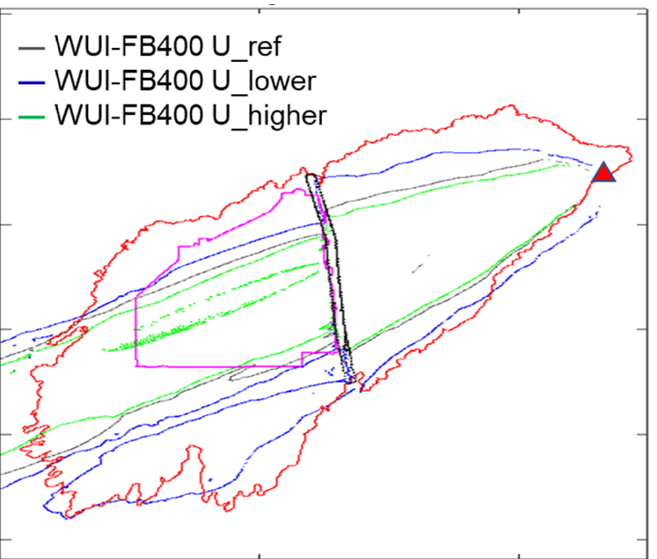
Figure 8. Contour line plot of fire arrival time at time = 11.5 h into the simulation for the reference constant wind speed (WUI-FB400 U_ref), and 25% lower (WUI-FB400 U_lower) and 25% higher (WUI-FB400 U_higher) than the reference wind speeds. The locations of the ignition and WUI fuel break are indicated with a red triangle and black polygon, respectively. The red contour line indicates the observed burn perimeter at 18:00 PST on 8 November. The Paradise Township boundary is shown by a magenta polygon.